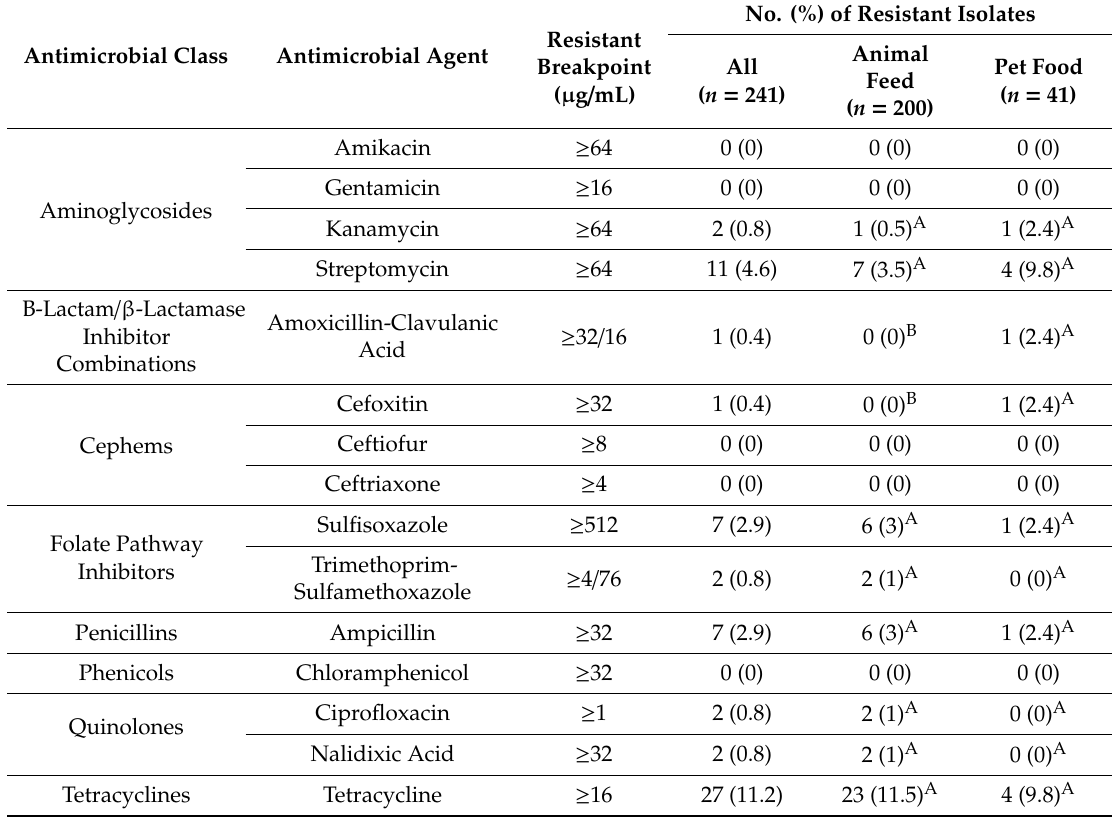
Table 2. AMR (antimicrobial resistance) profiles among 241 E. coli isolates by animal food category.